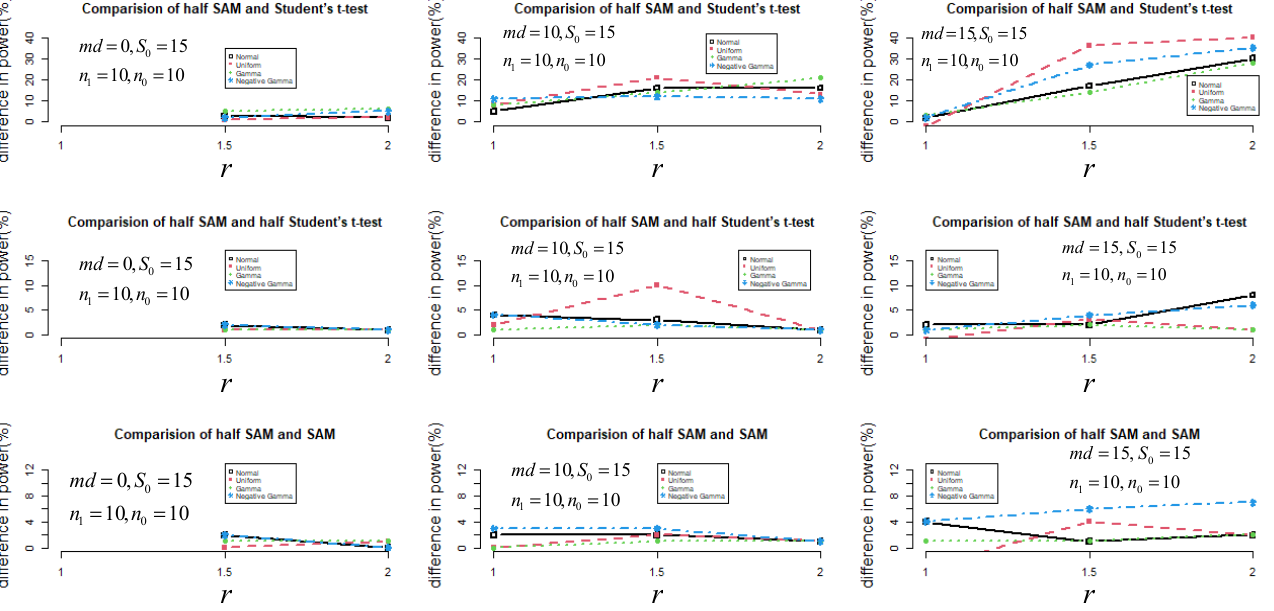
Figure 3. The difference in power (%) between half SAM and SAM (or half Student’s t -test and Student’s t -test) after controlling the FDR at